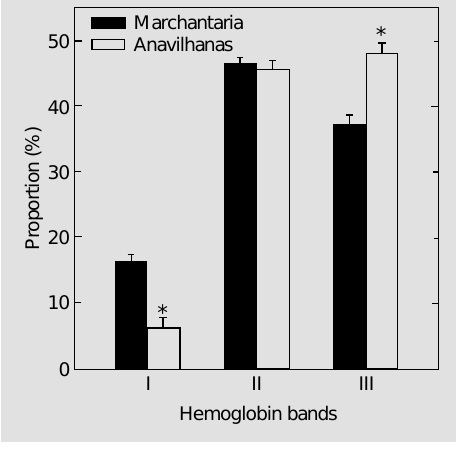
Figure 5 - Inorganic phosphate (Pi), adenosine triphosphate (ATP) and guanosine triphos- phate (GTP) in red blood cells of Callophysus macropterus col- lected from the Solimões River, near Marchantaria Island (filled columns), and from the Negro River, near Anavilhanas Archi- pelago (open columns). Asterisk indicates significant differences (P<0.05) between specimens from different collecting sites ( t -